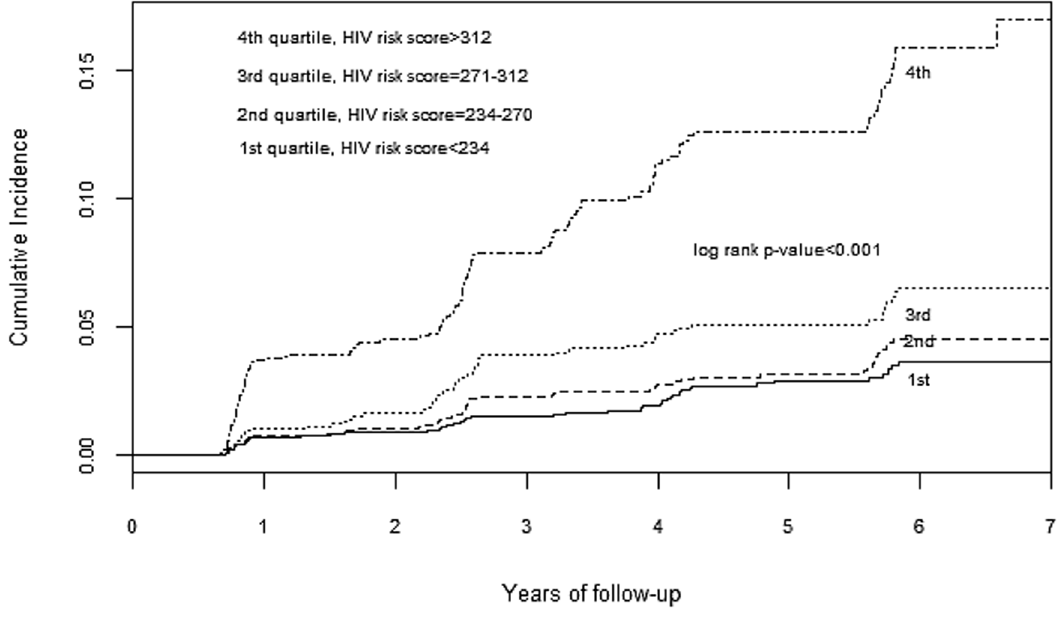
Figure 2. Cumulative HIV incidence by predicted quartile of HIV risk score for sexually active women.